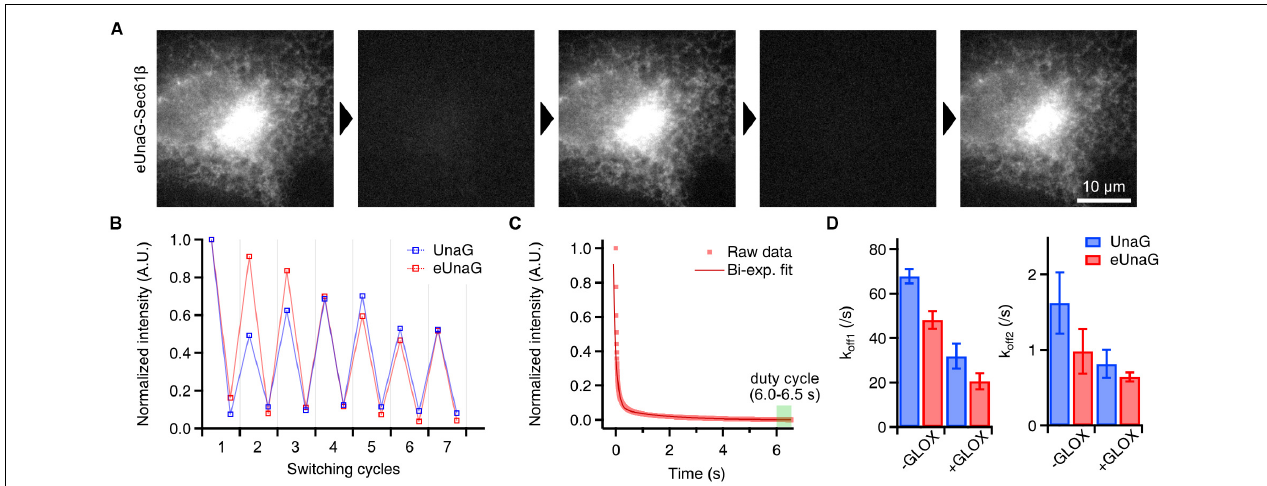
FIGURE 2 | Photoswitching behavior of eUnaG. (A) Widefield images of a fixed eUnaG-Sec61 β expressing Cos-7 cell showing repetitive fluorescence switching of eUnaG. Images were obtained from two successful rounds of fluorescence switching (off-switching: 300 W/cm 2 of 488-nm laser for 20 s; on-switching: 1 µ M bilirubin for 5 min). (B) Repetitive on- and off-switching of UnaG and eUnaG proteins. Fluorescence intensities were measured from a series of widefield images as in (A) and normalized to the initial value. (C) Fluorescence intensity trace of eUnaG under 300 W/cm 2 of 488-nm laser illumination. The decaying profile was well fitted by a bi-exponential function, giving two off-switching rates, k off1 and k off2 . The duty cycle was calculated from the average intensity at the equilibrium state (6.0–6.5 s). (D) Two off-switching rates of UnaG and eUnaG under different concentrations of dissolved oxygen (number of measurements: 5 for UnaG -GLOX, 14 for UnaG +GLOX, 6 for eUnaG -GLOX, 12 for eUnaG +GLOX). UnaG and eUnaG showed a similar tendency of slower off-switching rates with lower concentration of dissolved oxygen (+GLOX), in both k off1 and k off2 . Error bars: